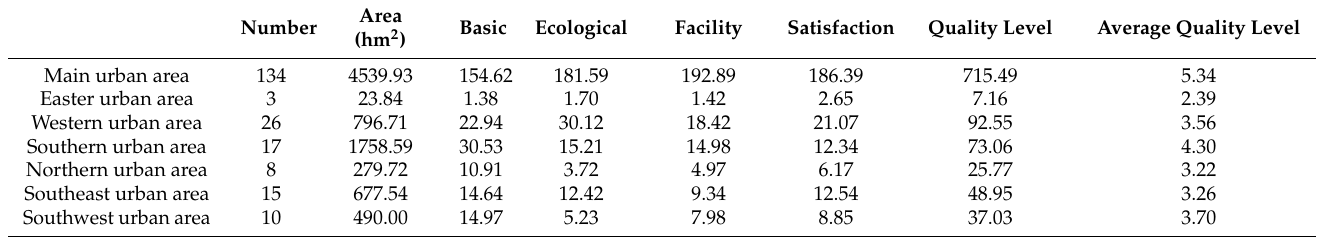
Table 4. Statistics on the quality level of ecological recreational space in different urban areas.